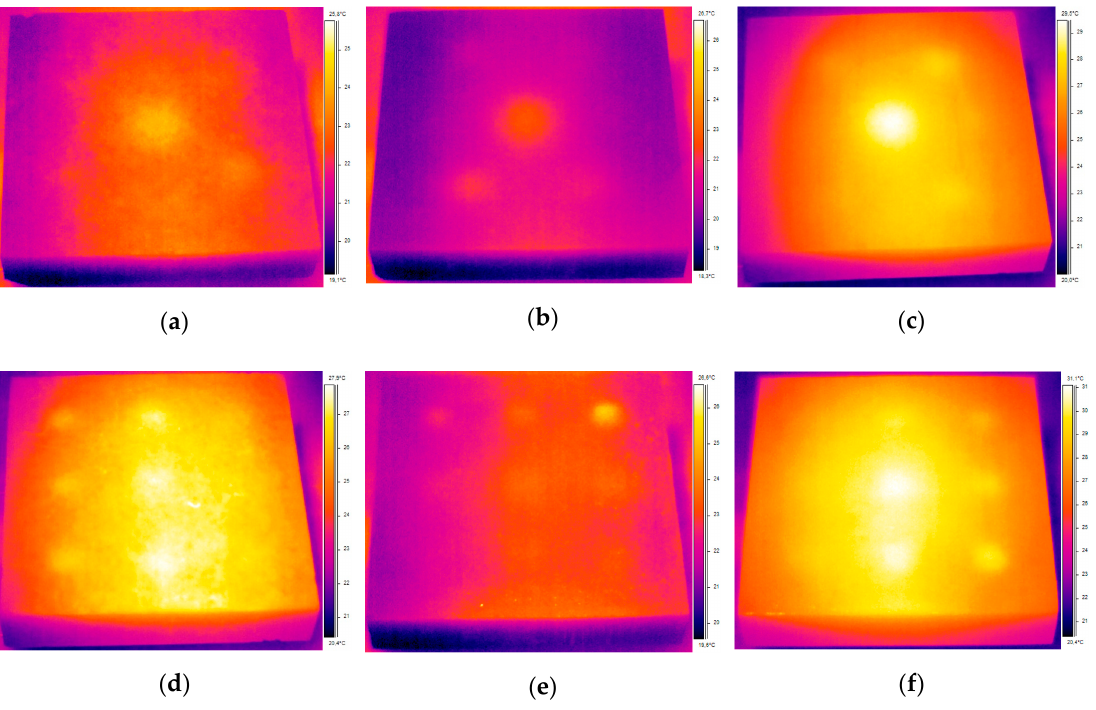
Figure 6. Optimal thermograms acquired for different concrete qualities: ( a ) BM 1–1 (t opt = 170 s); ( b ) BM 2–1 (t opt = 170 s); ( c ) BM 3–1 (t opt = 100 s) – thermal excitation distance 2 m, bottom side and ( d ) BM 1–2 (t opt = 120 s); ( e ) BM 2–2 (t opt = 50 s); ( f ) BM 3–2 (t opt = 50 s) – thermal excitation distance 2 m, top side.